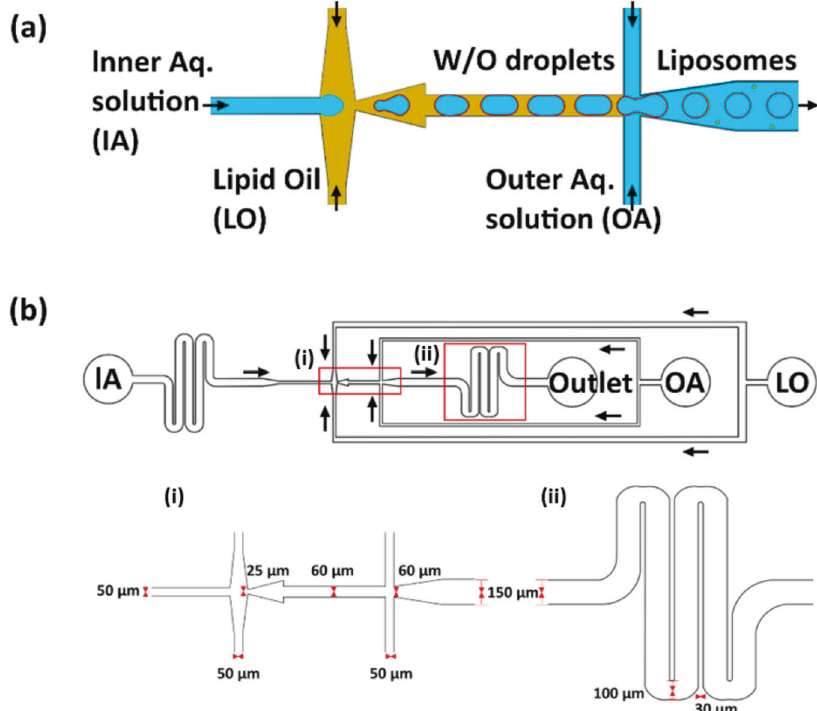
Fig. 1 Micro fl uidic device design. a Schematic representation of liposome production using double a cross-junction design and b design of the micro fl uidic chip used in this study with details on various inlets and the fl ow directions (black arrows) from various channels. Insets show (i) the dimensions of the two cross-junctions (ii) and the second serpentine module after the